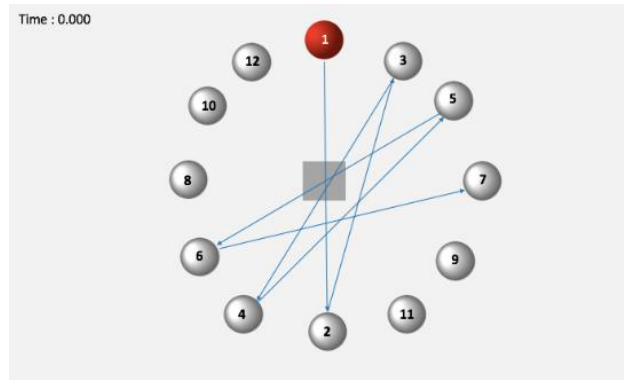
Figure 5. The pointing sequence of virtual red balls during multidirectional tapping task (shown as ball 1) [8] . ball 1)